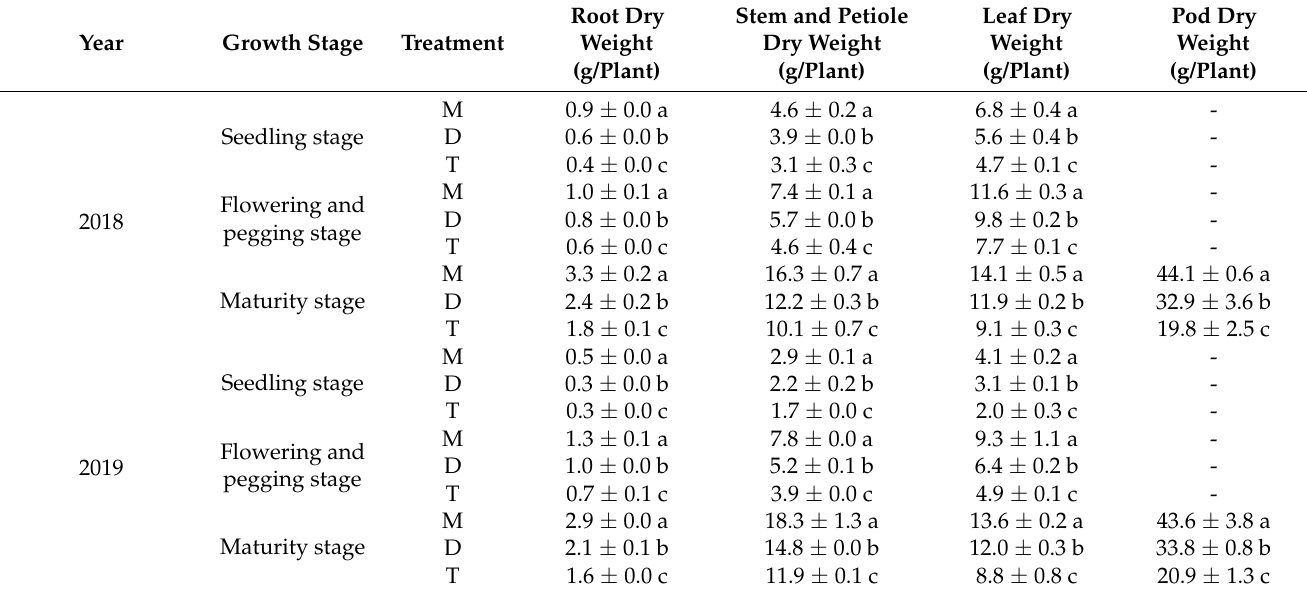
Table 8. Effect of seeding pattern on dry matter accumulation of peanut at different growth stages in 2018 and 2019.